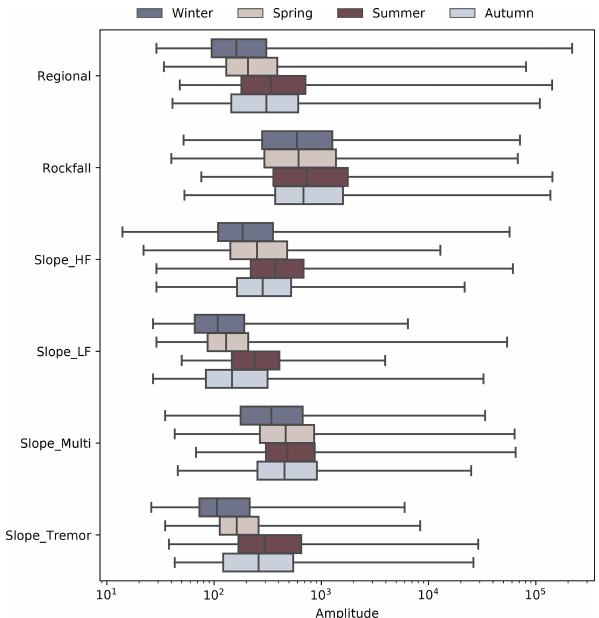
Figure B14. Box plots showing the distribution of amplitudes for each event class by season. Amplitudes in summertime are systematically higher than during the rest of the year.